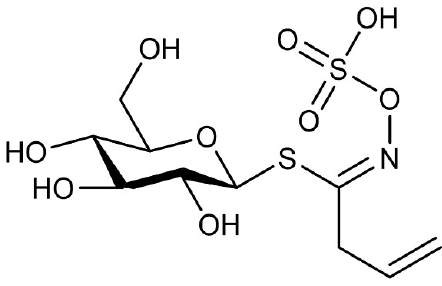
Figure 1. Chemical structure of sinigrin.